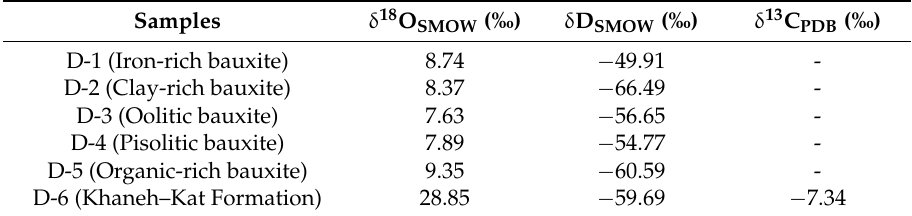
Table 6. Stable isotope composition of selected samples from the Dopolan bauxite deposit.